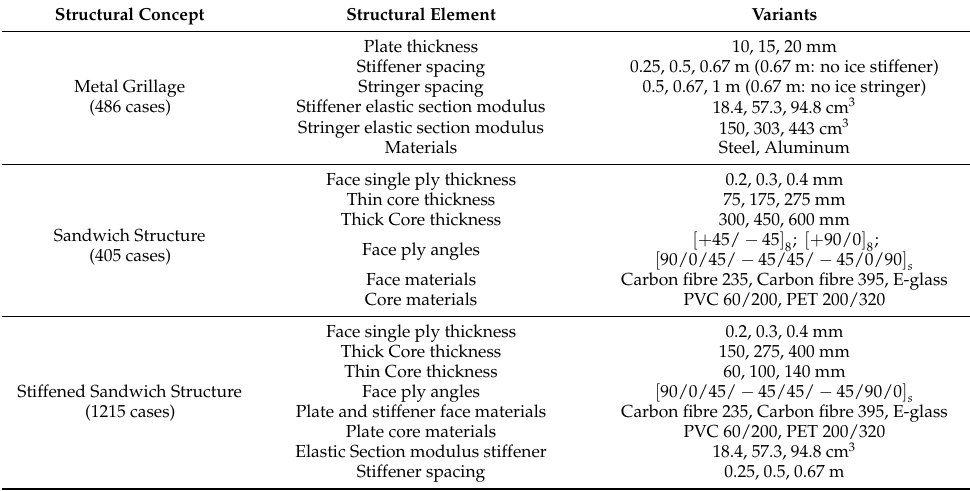
Table 2. Parametrization of structural